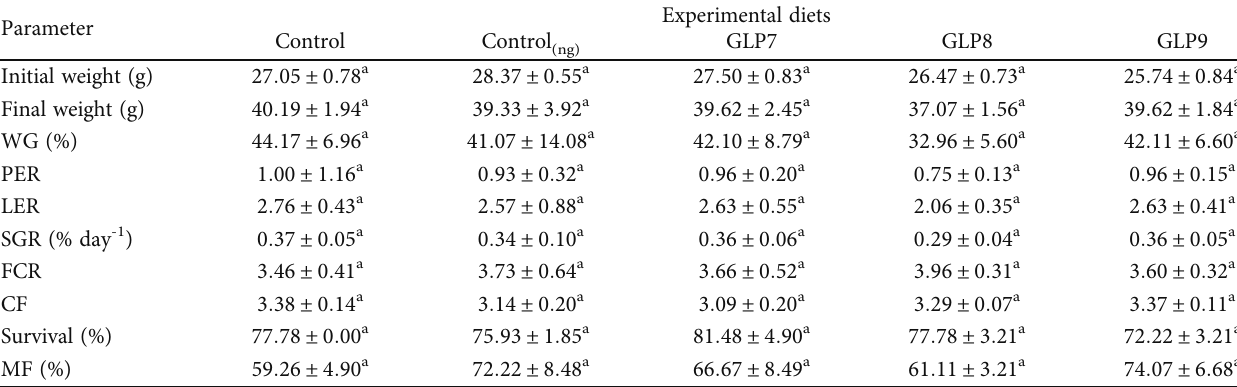
Data in the same row with di ff erent superscripts are signi fi cantly di ff erent ( P < 0 : 05 ). Values are presented as mean ± SE . WG: weight gain; PER: protein e ffi ciency ratio; LER: lipid e ffi ciency ratio; SGR: speci fi c growth rate; FCR: feed conversion rate; CF: condition factor; MF: molting frequency; Control: basal diet; Control (ng) : basal diet+2% GOS; GLP7: GOS+ L. plantarum ( 2 % + 10 7 CFUg -1 diet); GLP8: GOS+ L. plantarum ( 2 % + 10 8 CFUg -1 diet); GLP9: GOS+ L. plantarum ( 2 % + 10 9 CFUg -1 diet). Table 3: Di ff erential hemocyte counts of narrow-clawed cray fi sh fed with di ff erent experimental diets after 97 days feeding trials (1 st sampling time; 1 st ST) and 24h post air exposure challenge (2 nd sampling; 2 nd ST).